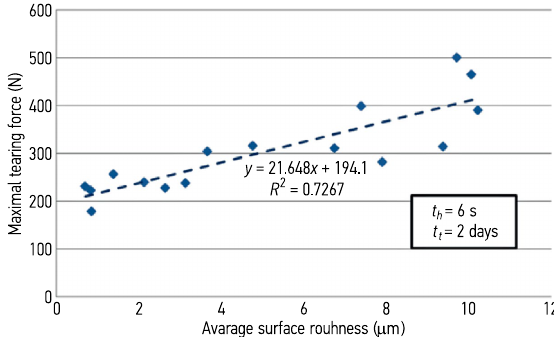
Fig. 10. Effect of surface roughness on maximal tearing